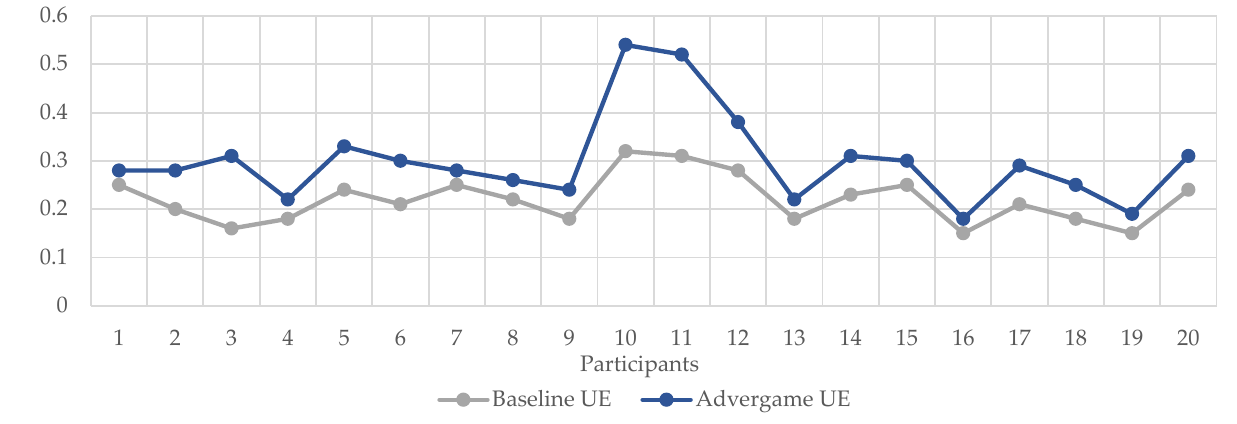
Figure 5. UE index during the advergame interaction.